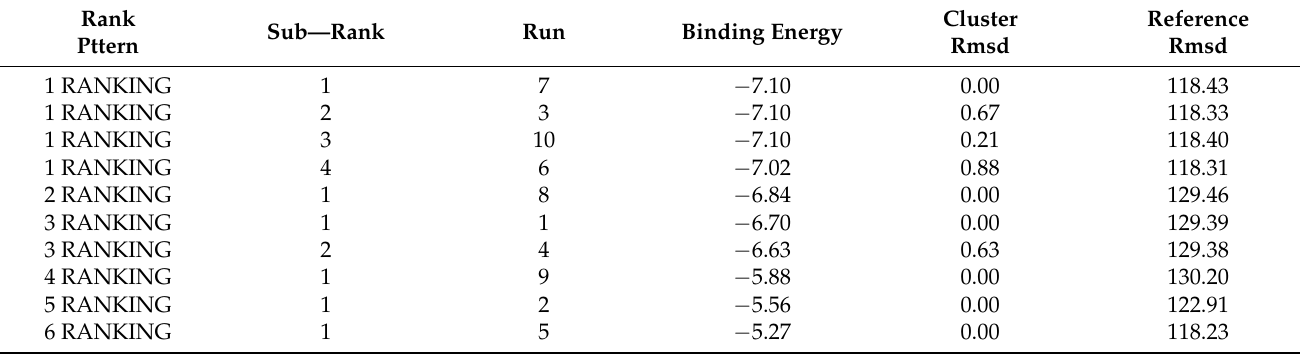
Table 1. Binding energy (kcal/mol) for docked complex demonstrating the interaction between allicin and PD-L1 . Rank